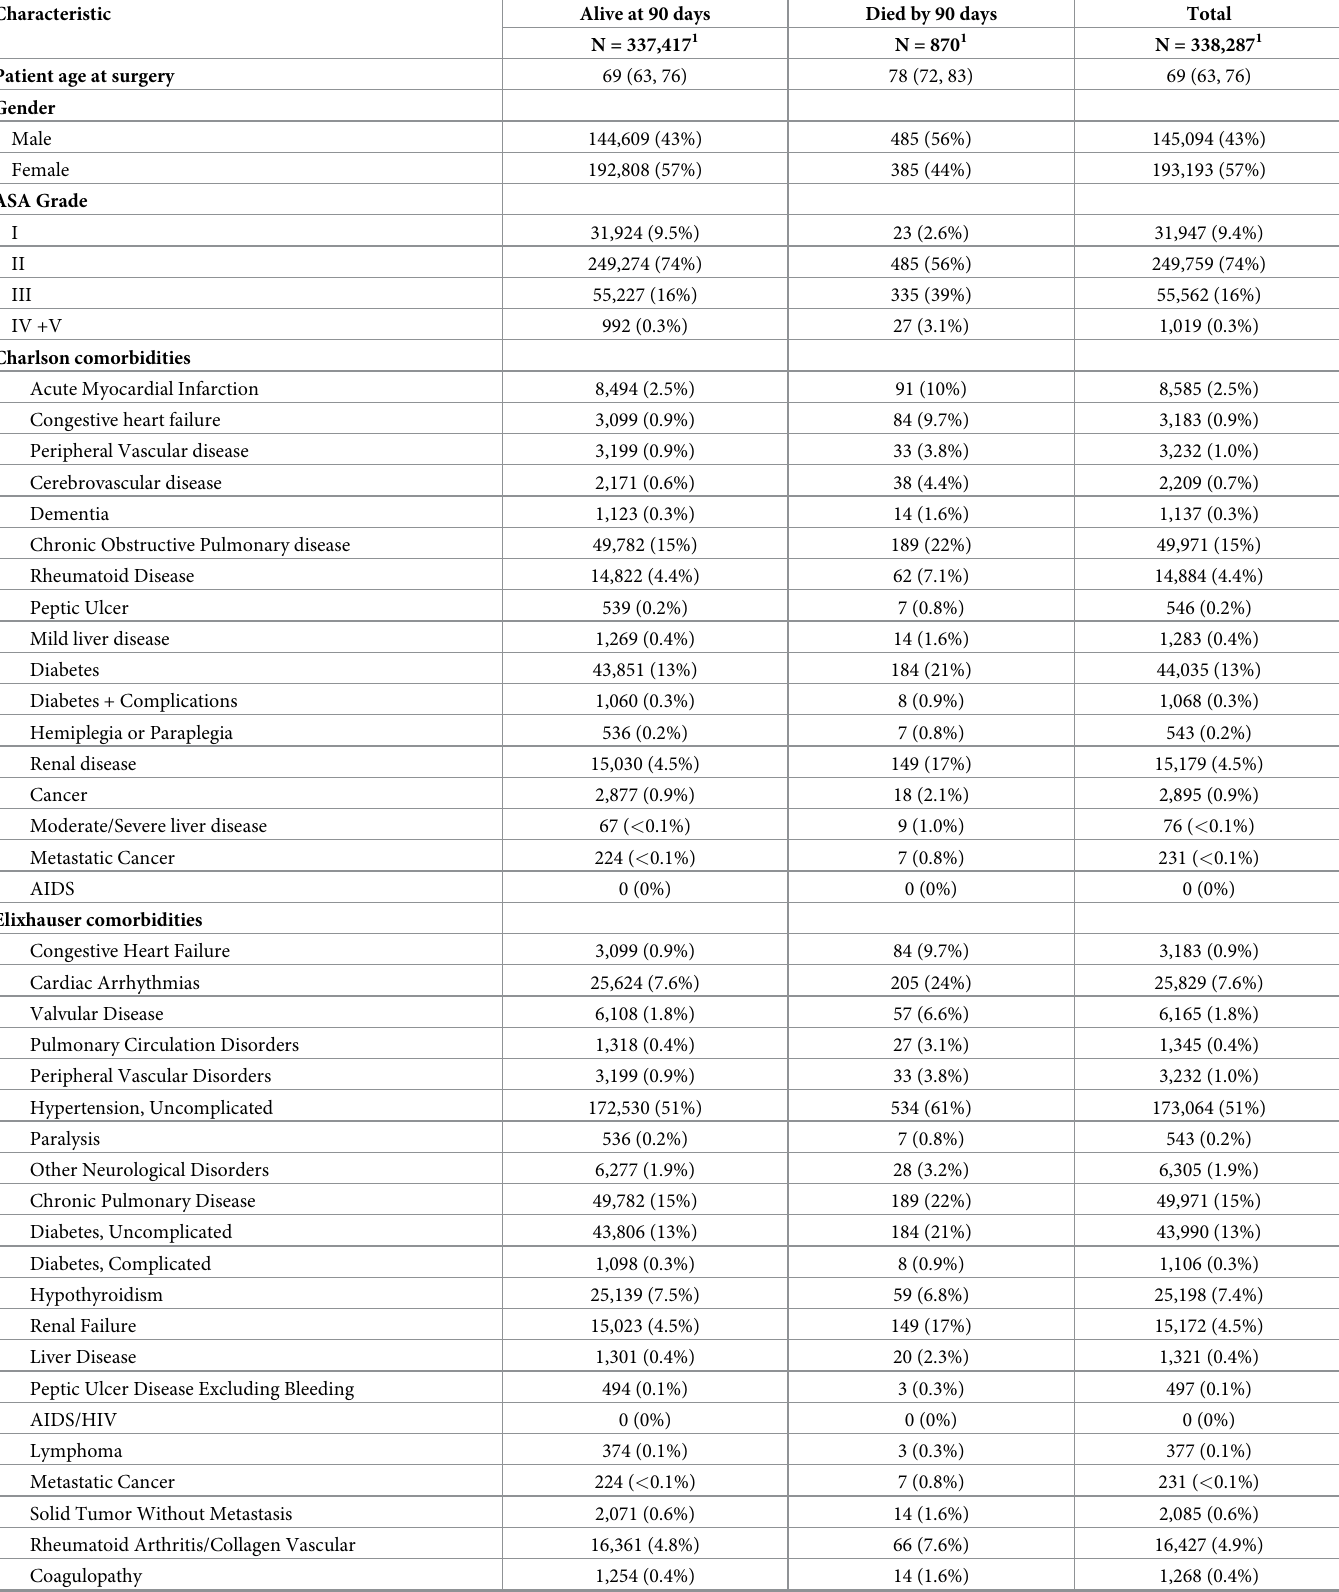
Table 2. The characteristics of people having a primary KR, including by 90-day